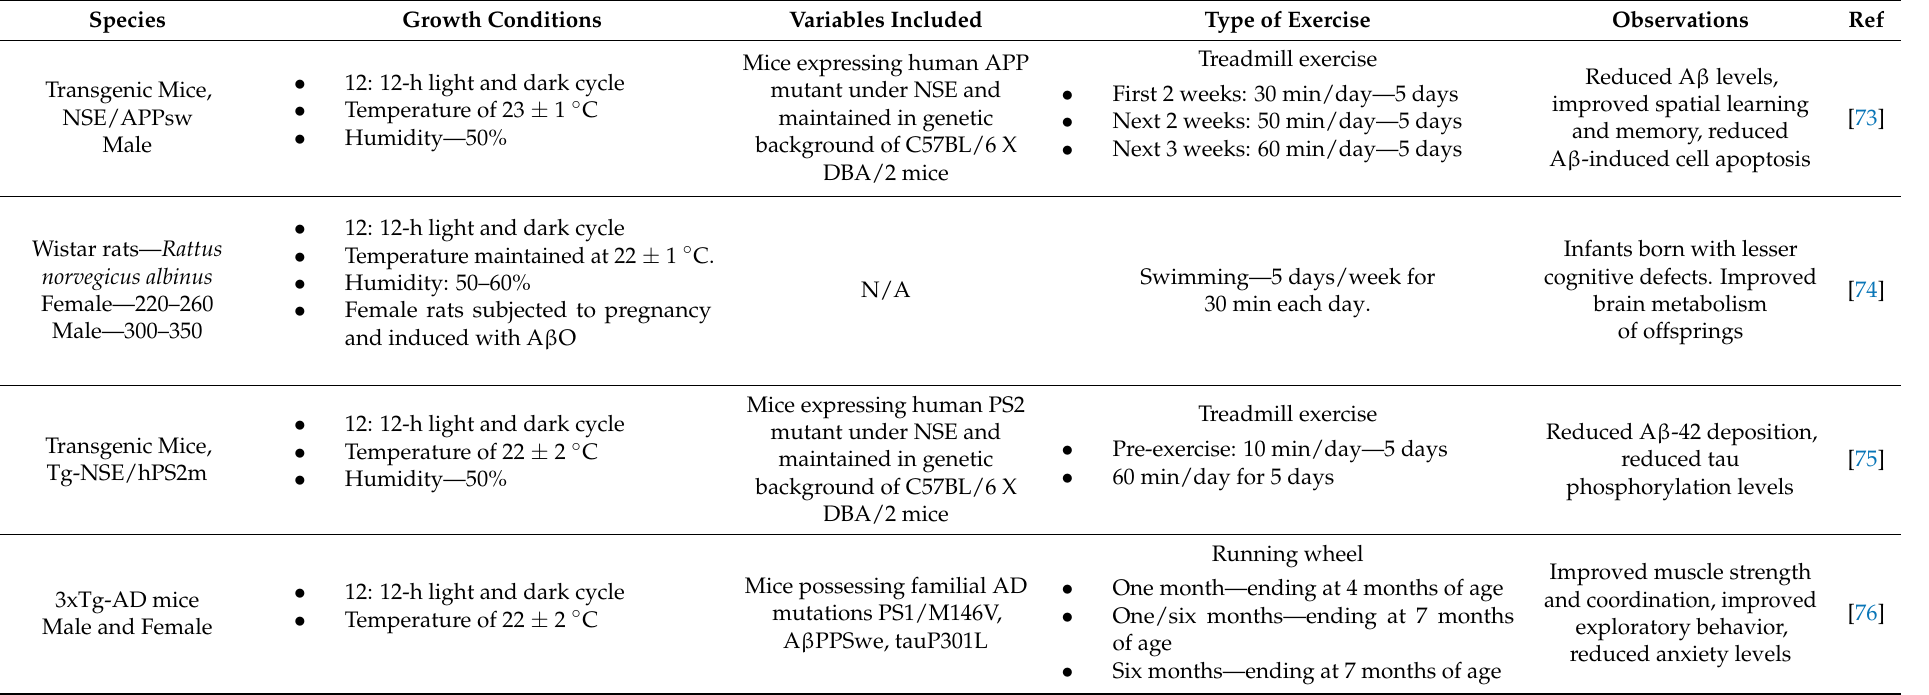
Table 4. Exercise and Alzheimer’s disease in